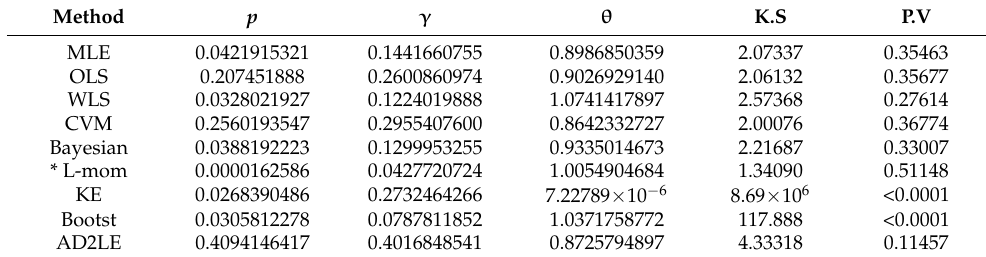
Figure 6. Kaplan–Meier plots for dataset IV. Table 11. Comparing methods for dataset